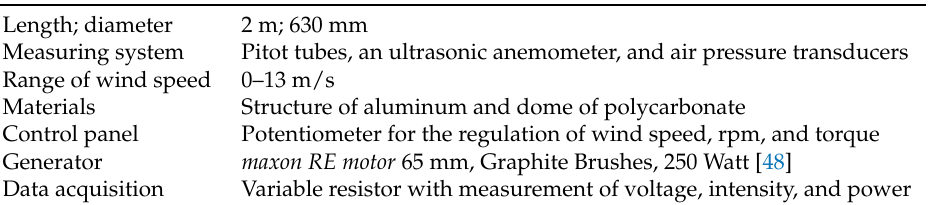
Table 1. Characteristics of the wind